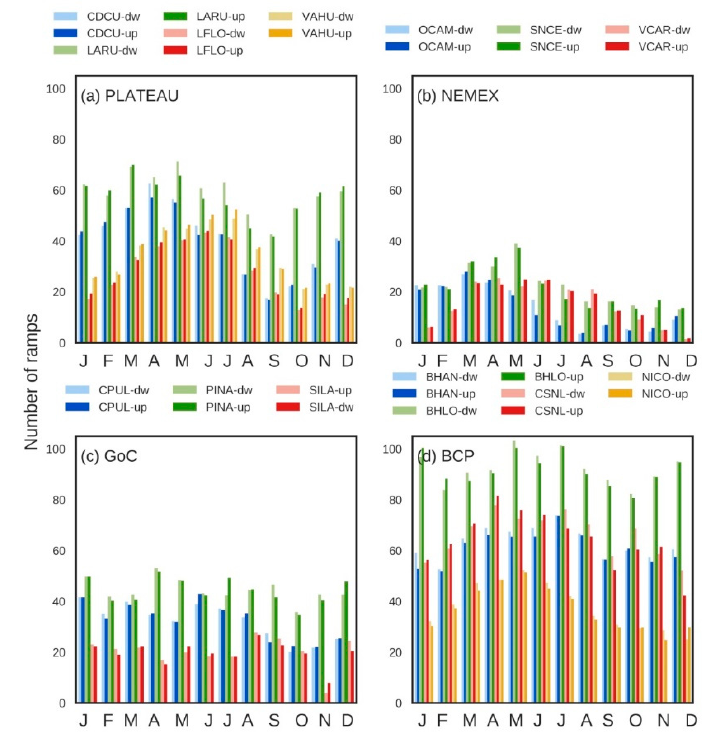
Figure 4. Monthly mean of wind power ramp-up (dark color) and ramp-down (light color) events for ( a ) Plateau, ( b ) NEMEX, ( c ) GoC, ( d ) BCP